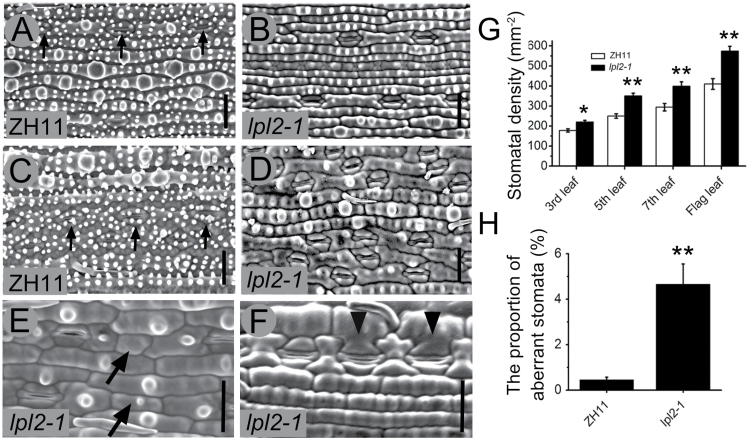

lpl2-1 showed increased stomatal density and aberrant stomata. SEM images of the third abaxial leaf in ZH11 (A), and lpl2-1 (B). SEM images of the abaxial side of flag leaf in ZH11 (C) and lpl2-1 (D). Vertical arrows present stomata. (E, F) SEM images of aberrant stomata in lpl2-1. Diagonal arrows indicate GMC-like cells. Arrowheads indicate aberrant SCs. Bars, 20 μm. (G) Stomatal density of ZH11 and lpl2-1, n>100. (H) The proportion of aberrant stomata in ZH11 and lpl2-1, n>6000. Error bars represent SD; *, P<0.05; **, P<0.01 (Student’s t-test).